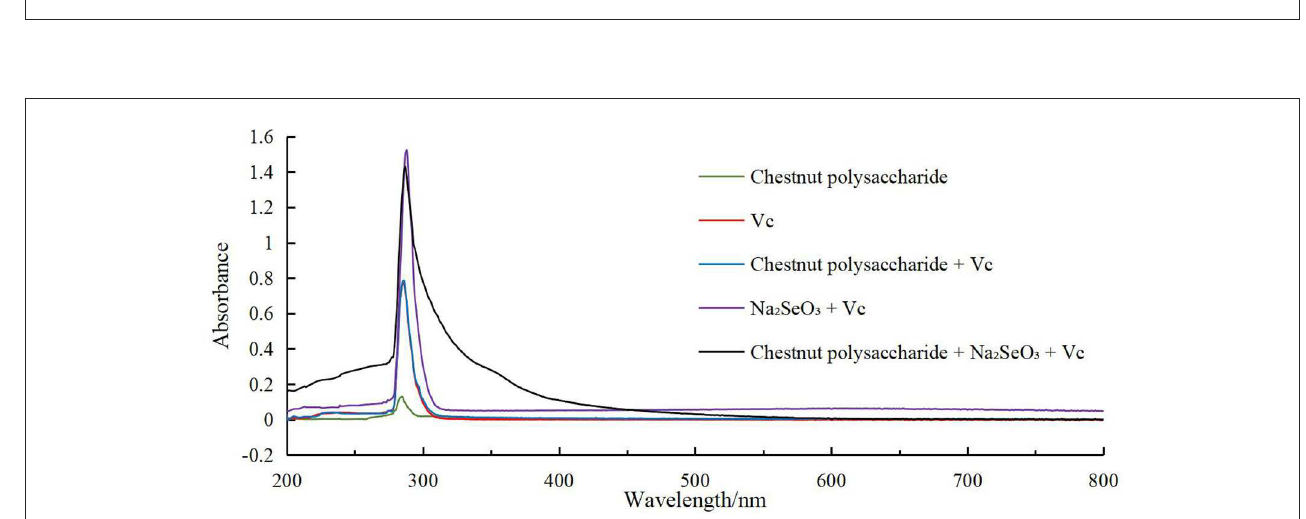
FIGURE10 Full wavelength scanning result